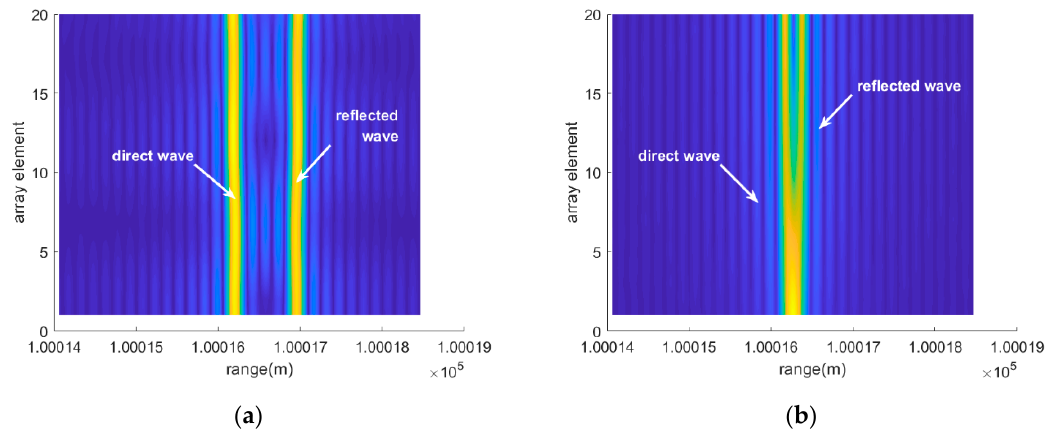
Figure 4. The RA graphs with FFT when the elevation angles are 6° and 1°, ( a ) and ( b ), respectively.